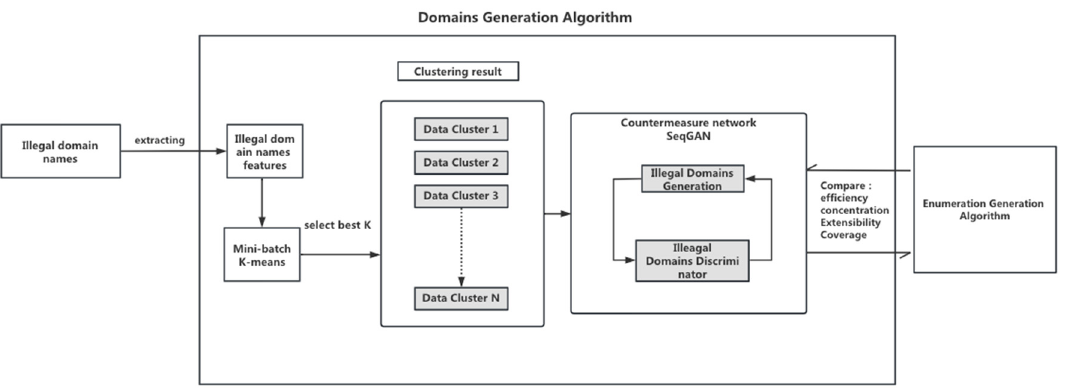
Figure 1. Generation algorithms process.